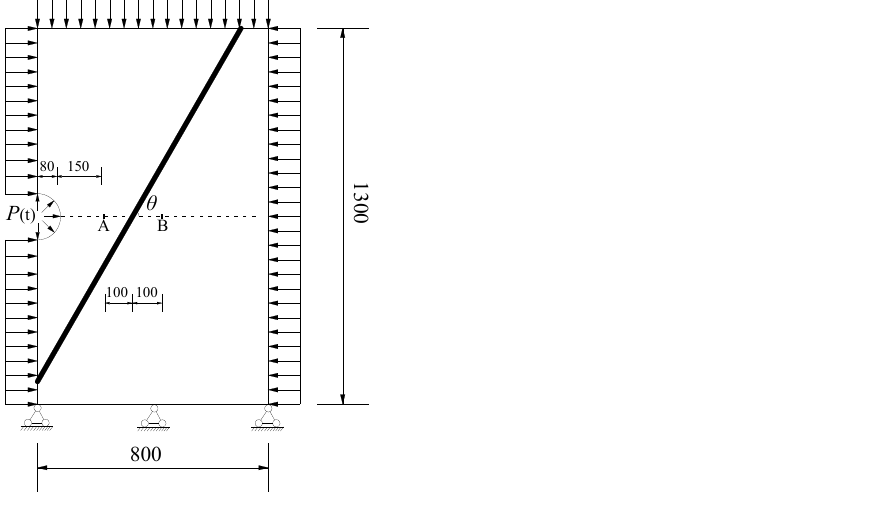
Figure 11. Numerical model containing one single joint with different angles (unit: mm).